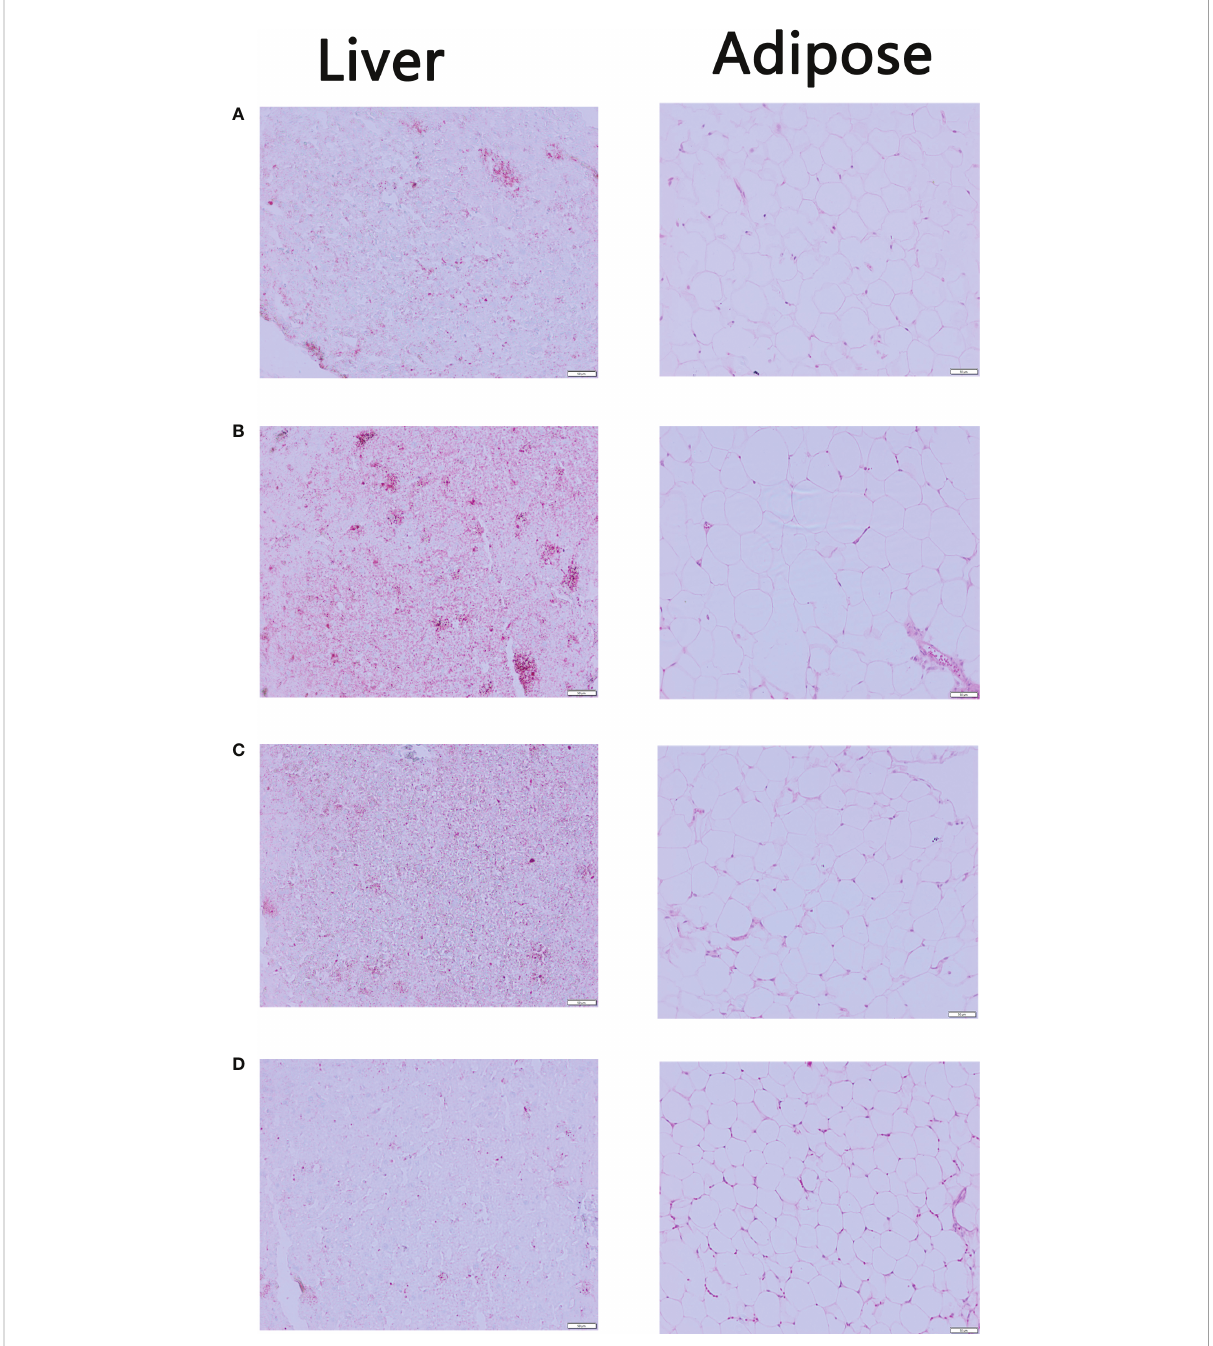
FIGURE 3 The mice liver sections stained by Oil red O and adipose sections stained by HE (×200) (A) Control Group (B) Model Group (C) Low-dose Group (D) High-dose